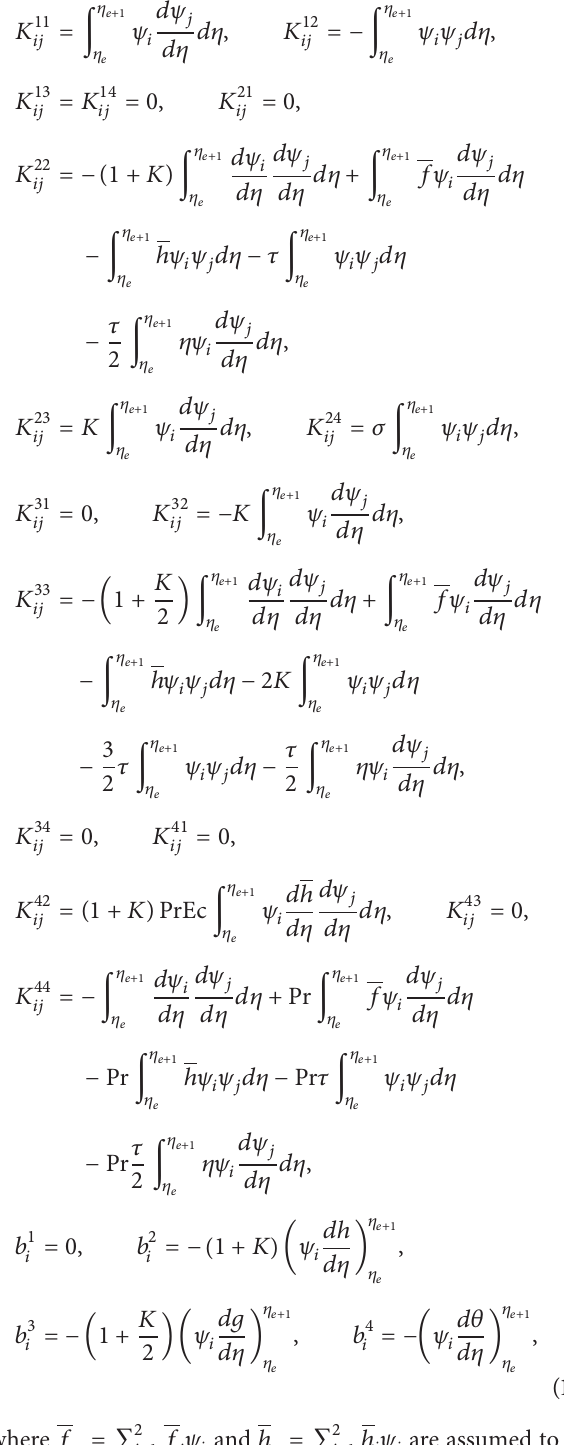
Table 1: Convergence of results with the variation of number of